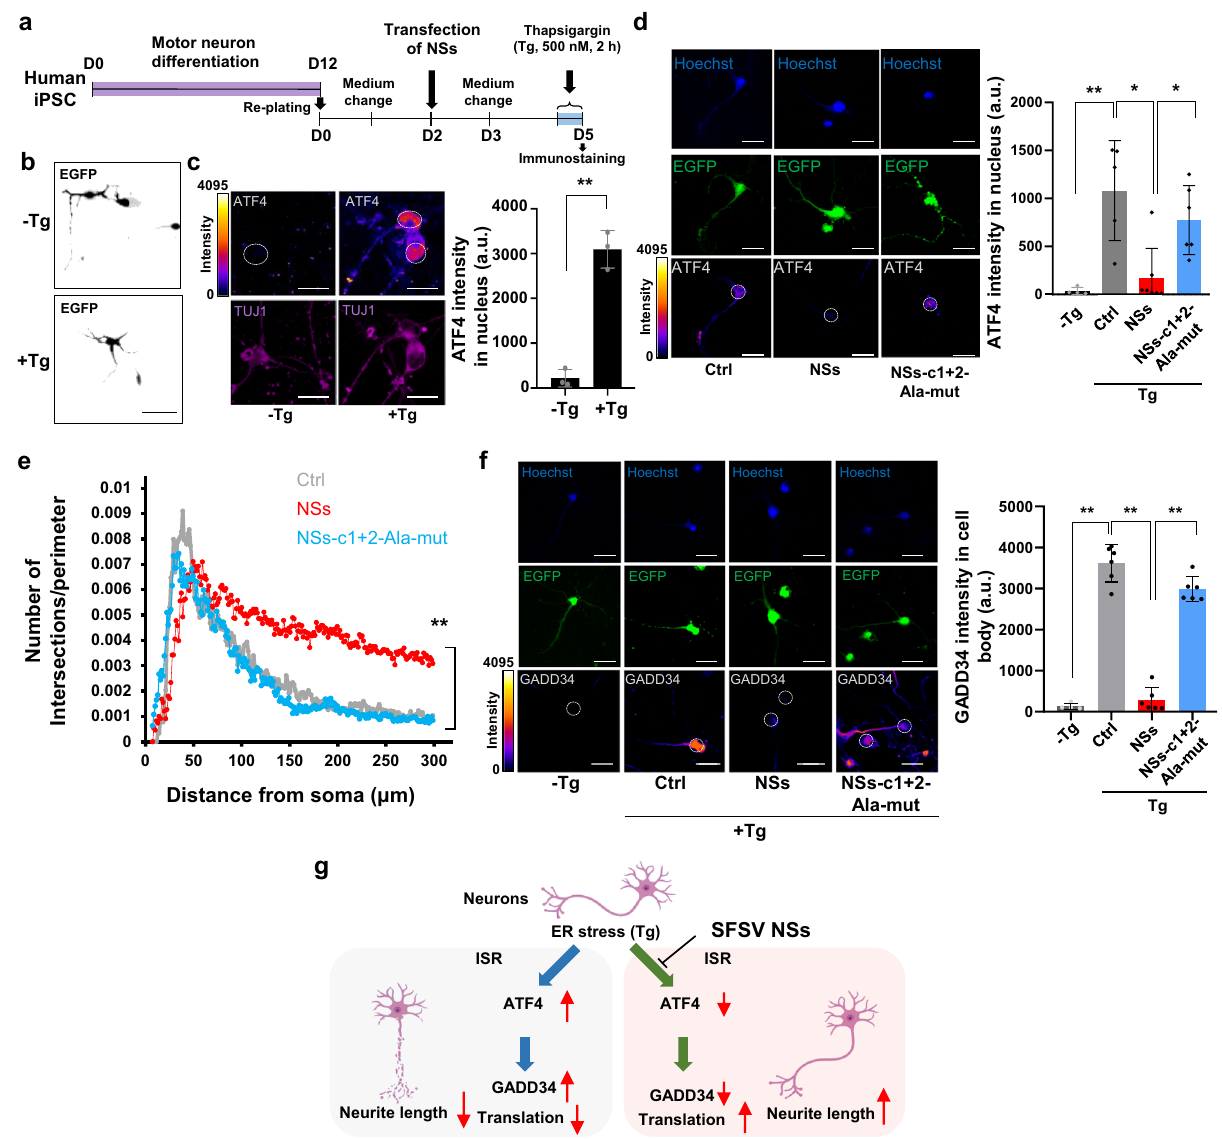
Fig. 6 SFSV NSs in human iPS cell-derived motor neurons attenuates the ISR induction and exhibits neuroprotective effects. a Motor neuron differentiation from human iPS cells and the timing of NSs transfection and drug administration. After motor neurons were replated onto glass coverslips, they were transfected with the control plasmid, the SFSV NSs-expression plasmid, or the SFSV NSs-c1 + 2-Ala-mut-expression plasmid by Lipofectamine 3000 for 2 days. After additional 3 days, the neurons were treated with thapsigargin (Tg; 500 nM) for 2 h, followed by fi xation and immunostaining of ATF4. b Representative images of motor neurons with or without Tg treatment. Scale bar = 50 µ m. c Tg signi fi cantly induced the stress response, as represented by ATF4 upregulation in motor neurons. n = 3. Scale bar = 10 µ m. ** p < 0.01. d ATF4 intensity in control, SFSV NSs-expressing, and SFSV NSs- c1 + 2-Ala-mut-expressing motor neurons after Tg treatment. In SFSV NSs-expressing motor neurons, ATF4 was signi fi cantly downregulated, whereas mutant SFSV NSs expression did not alter ATF4 protein levels as compared to the control. n = 3. * p < 0.05. Scale bar = 10 µ m. e Sholl analysis in motor neurons. NSs expression increased the length of axons as compared to the control and NSs-c1 + 2-Ala-mut expression. n = 5. f ISR triggered a signi fi cant increase of immunoreactivity to the GADD34 antibody. In addition, NSs treatment signi fi cantly decreased the expression level of GADD34, whereas NSs- c1 + 2-Ala-mutant did not alter the GADD34 level as compared to the control. n = 5. Scale bar = 10 µ m. g Illustration of ISR induction and NSs effect upon ER stress in neurons. n means the number of independent experiments * p < 0.05; ** p < 0.01. h Student ’ s t -test; d – f One-way ANOVA with Tukey ’ s multiple comparisons test. Error bars ±SD. c , d , f a.u., arbitrary units. The 12-bit scale of fl uorescent intensity is shown at color coded. Source data are provided as a Source Data fi of ATF4 1 (Fig. 6f). In the same manner as the ATF4 regulation, SFSV NSs signi fi cantly decreased the expression level of GADD34 along with ATF4 downregulation, whereas the NSS-c1 + 2-Ala- mutant did not alter the GADD34 level as compared to the control. Although GADD34 serves as a negative-feedback-loop regulator for the eIF2 α -ATF4 pathway, it is also known that GADD34 induces cell death through the suppression of Akt 34 .